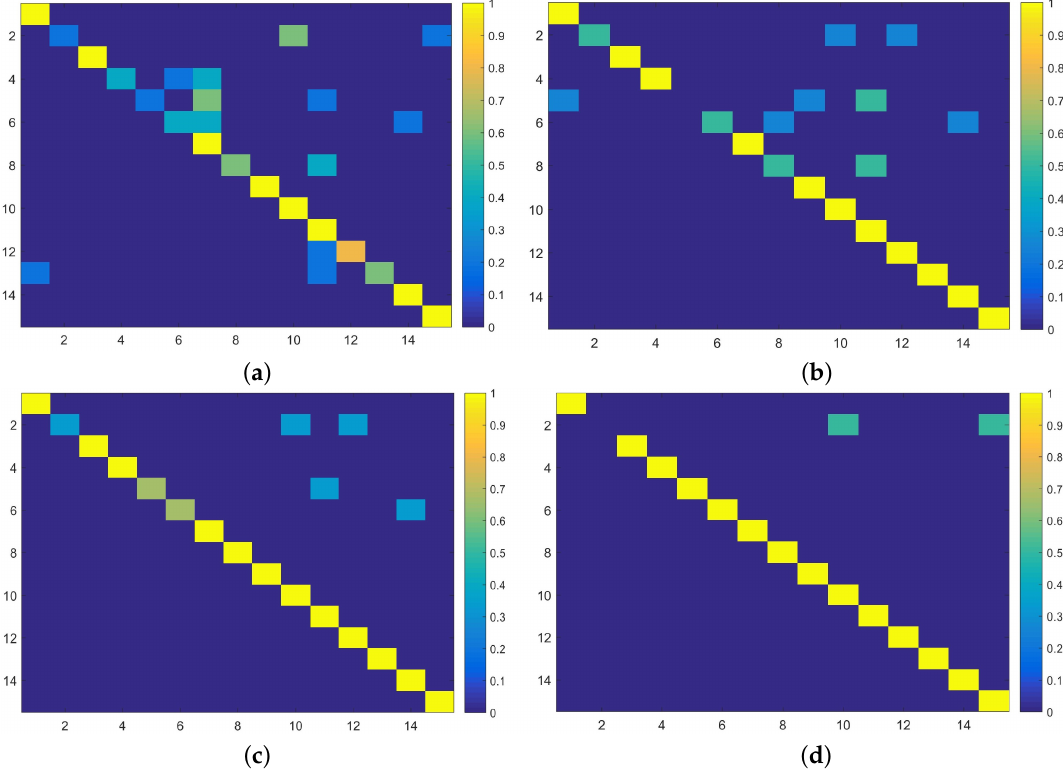
Figure 4. Confusion matrices using the SURF feature detector under different database percentages as the training samples. ( a ) Using 30% of the database as the training set (30 images out of 105), ( b ) Using 45% of the database as the training set (45 images out of 105), ( c ) Using 60% of the database as the training set (60 images out of 105), and ( d ) Using 75% of the database as the training set (75 images out of 105). The horizontal axis represents the predicted class while the vertical axis represents the true